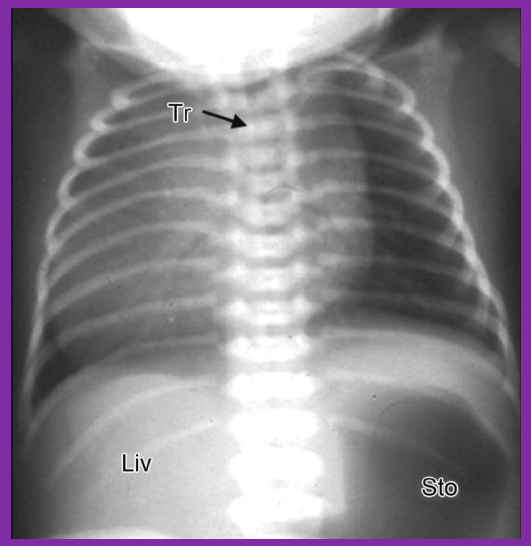
Figure 10. A chest roentgenogram of a baby illustrating dextrocardia along with normal visceral position (situs solitus) with the liver (Liv) on the right side and the stomach (Sto) on the left side, i.e., isolated dextrocardia. The tracheal (Tr) position in the middle is shown. The Sto is dilated, probably related to intestinal obstruction secondary to malrotation of the gut. Modified from reference